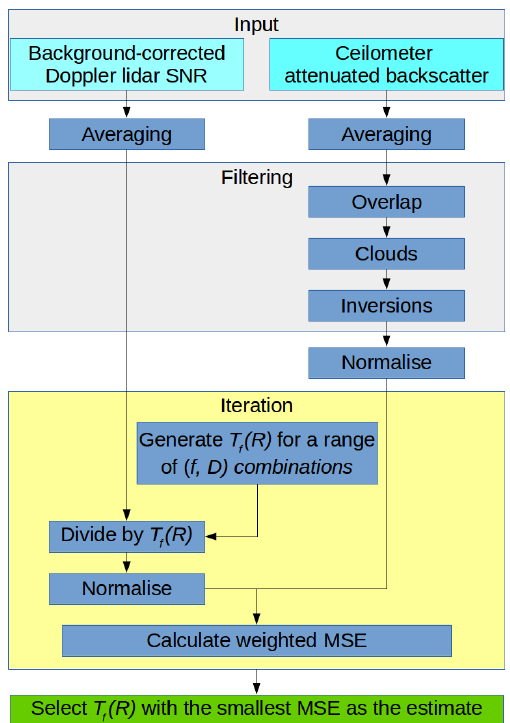
Figure 2. Process diagram of the telescope focus function parame- ter